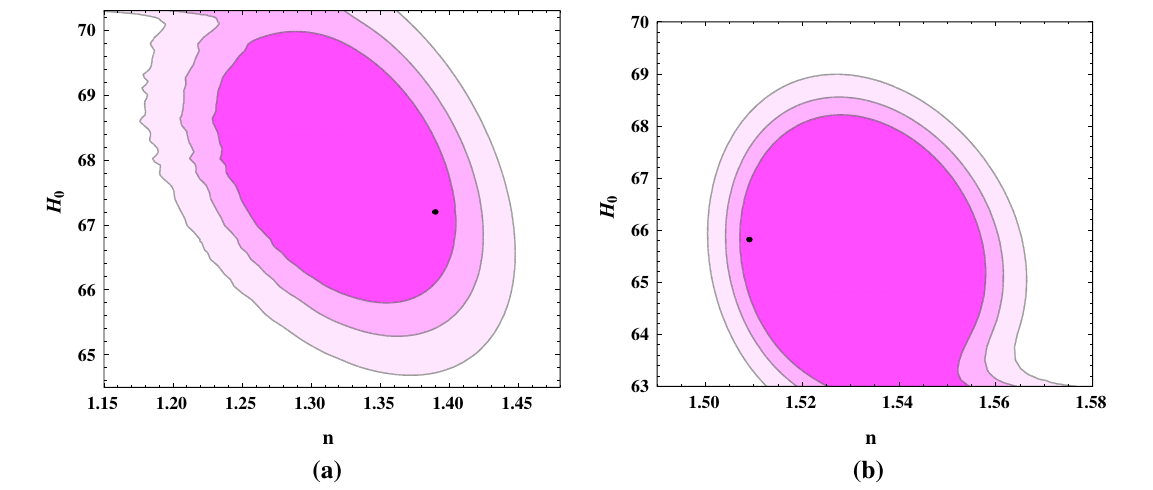
Fig. 11 Figures ( a ) and ( b ) show the likelihood contours in the n – H 0 planeforjointanalysis H ( z ) + SNeIaand H ( z ) + SNeIa + BAO,respec- tively. The dark shaded region shows the 1 σ error, light shaded region